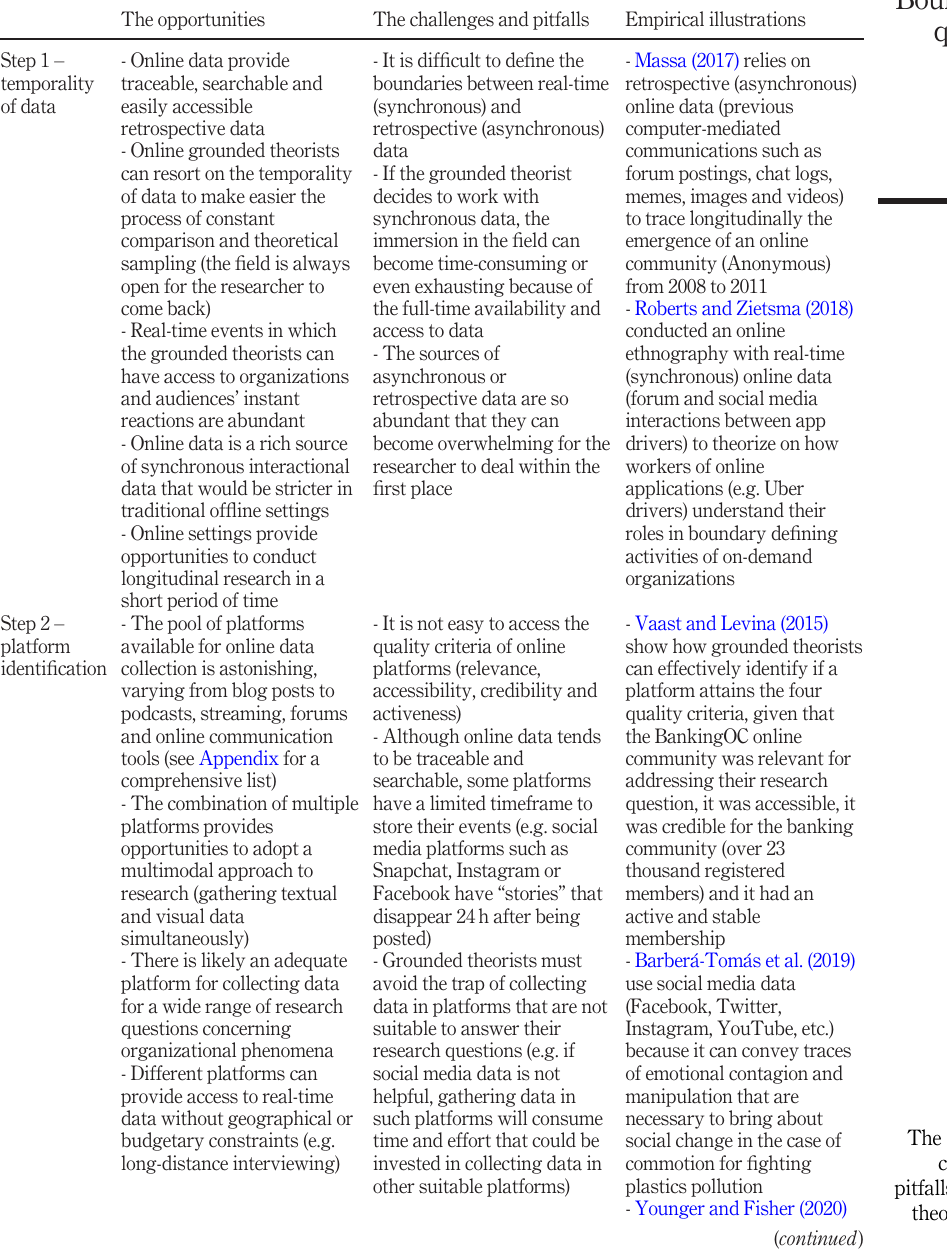
Table 1. The opportunities, challenges and pitfalls of